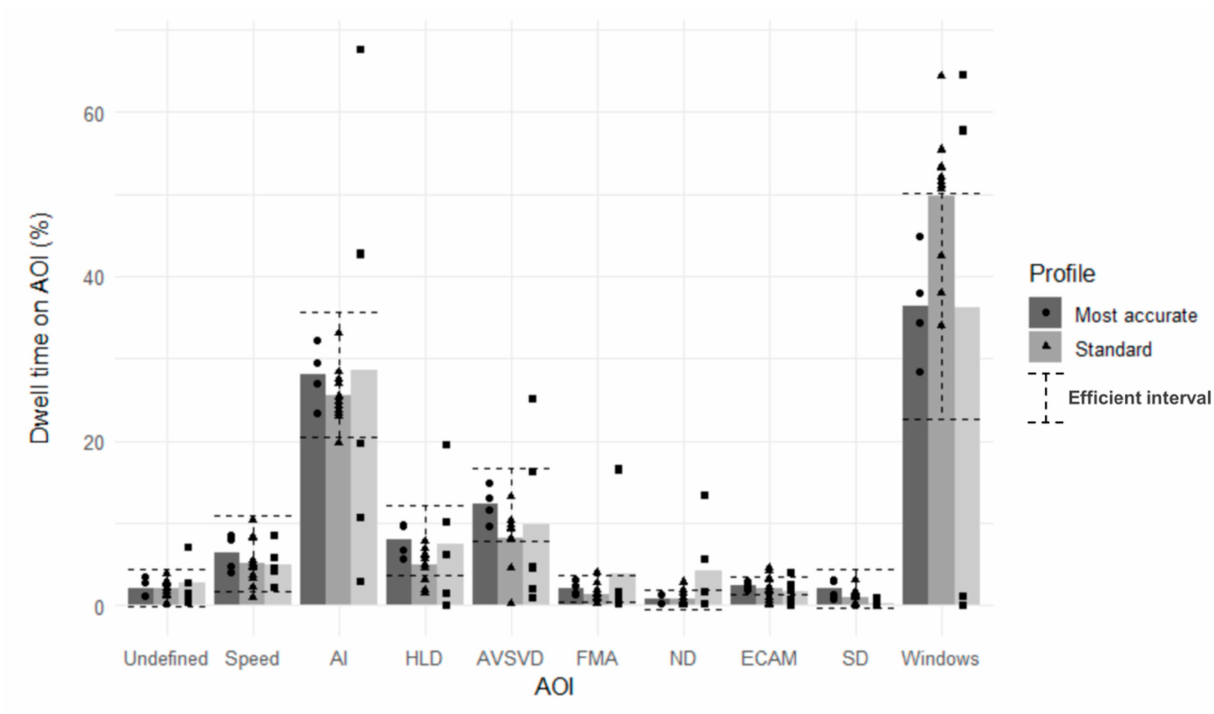
Figure 8. Percentage of dwell times on each cockpit AOI during the approach (pre-training session) for the most accurate and the unstabilized pilots (dots represent individual data). Undefined = undefined locations plus loss of gaze: the value is low, showing the high quality of the eye-tracking data and the fact that few fixations occurred outside the defined AOI. AI = Attitude Indicator; HLD = Heading/Lateral Deviation scales; AVSVD = Altitude/Vertical Speed/Vertical Deviation scales; FMA = Flight Mode Annunciator; ND = Navigation Display; ECAM = Electronic Centralized Aircraft Monitor system; and SD = System Display system. The dashed error bars indicate the interval spanning over the mean percentage of dwell times on each AOI of the most accurate pilots, plus/minus two standard deviations (labeled efficient dwell times